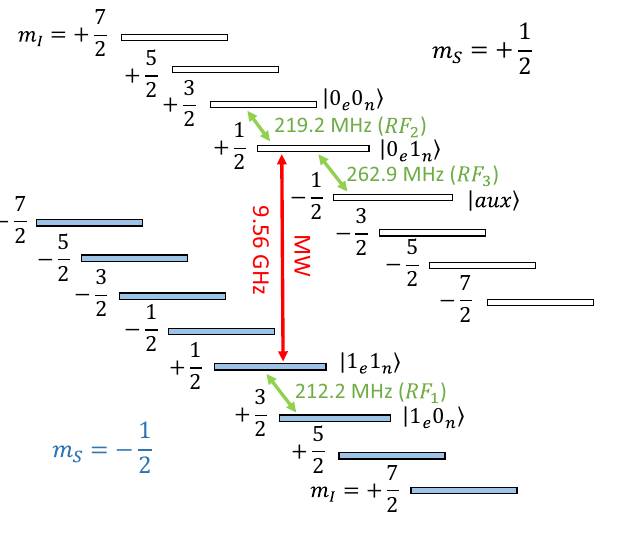
Fig. 4 The energy-level structure of the 4 I 9/2 (0) state of 143 Nd 3 + :Y 2 SiO 5 under an external magnetic fi eld of B 0 = 439.8 mT. The red arrow indicates the electron-spin-resonance transition between the þ 1 state. The green arrows represent the relevant nuclear- n magnetic-resonance transitions, whose frequencies are also labeled. aux j